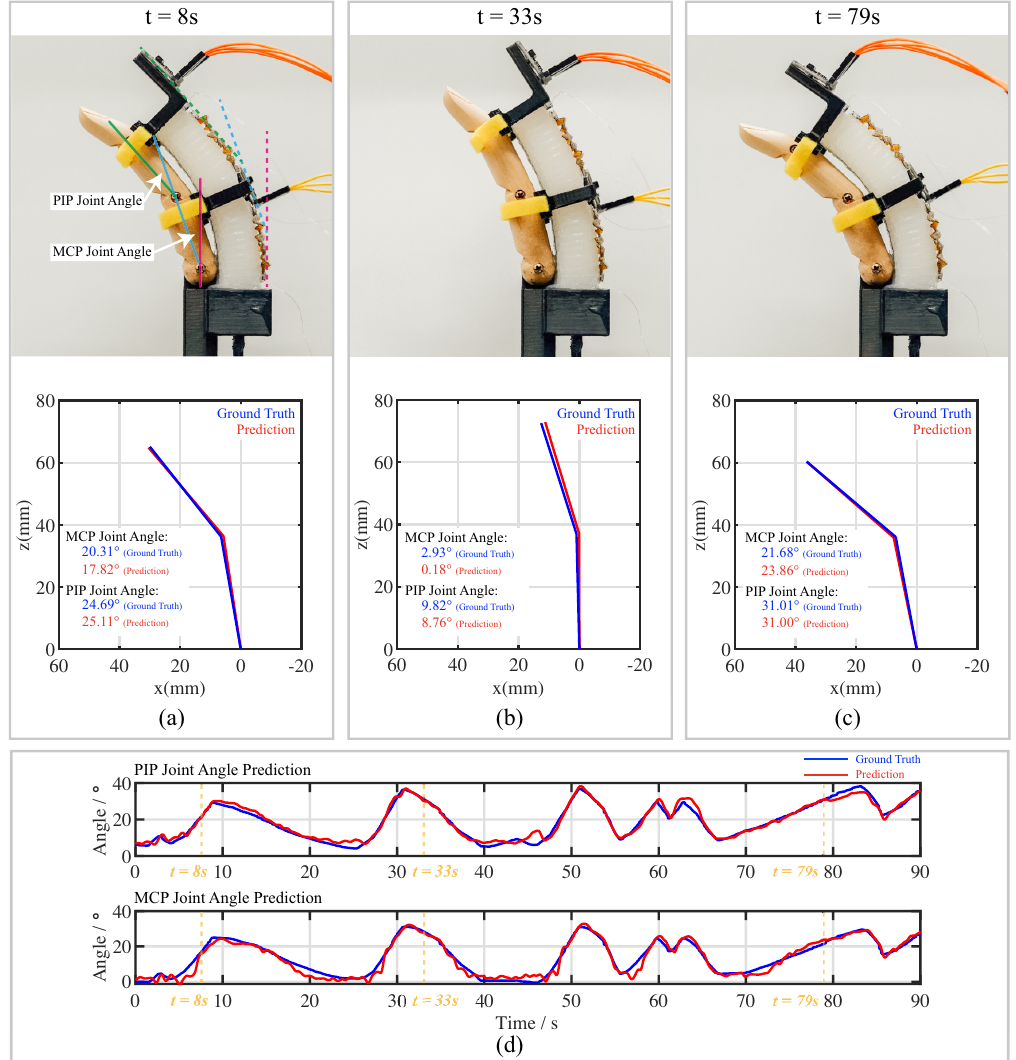
Figure 13. Finger-joint angle predictions using kirigami-inspired flexible sponge sensors. Top: photos of a wooden finger model with time step. Bottom: prediction of joints angles with ground truth. ( a ) Captured at t = 8 s; ( b ) Captured at t = 33 s; ( c ) Captured at t = 79 s. ( d ) Prediction of finger-joint angles within a 90 s time-fram (time steps of finger postures in ( a – c ) are listed). Red lines: prediction. Blue lines: ground